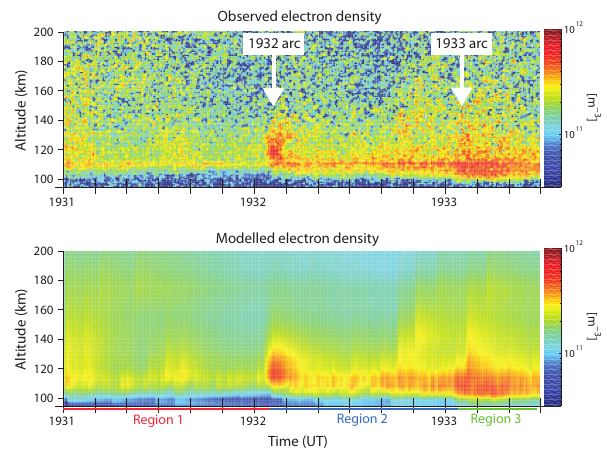
Fig. 7. Top: E-region enhancements in electron density correspond- ing to auroral arcs drifting over EISCAT. Bottom: Modelled elec- tron density.